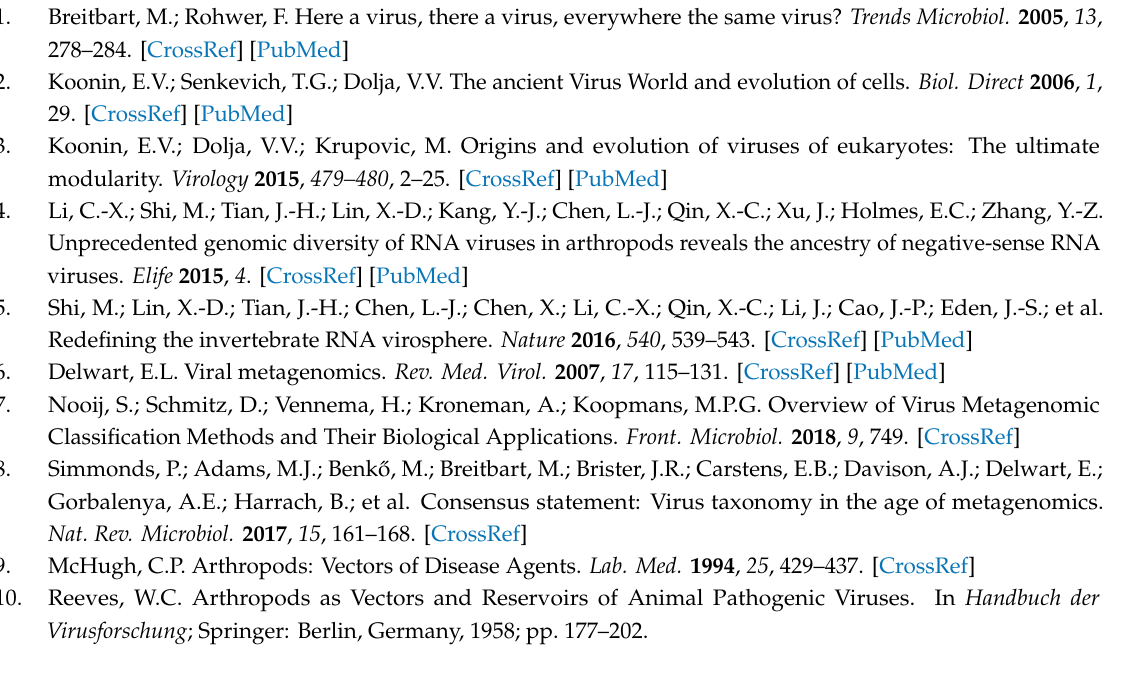
Figure S6: Phylogenetic trees showing the classification of two ORFS from M1C10 for hypothetical protein 1 (A) and hypothetical protein 2 (B). Figure S7: A novel relative of Motts Mill virus identified using a partial sequence in the midge pool one. Table S1: Cross and between sequencing run contaminations found in midge samples,